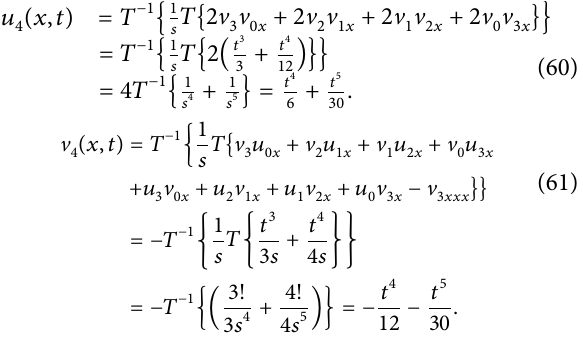
v for Example 𝑢 =